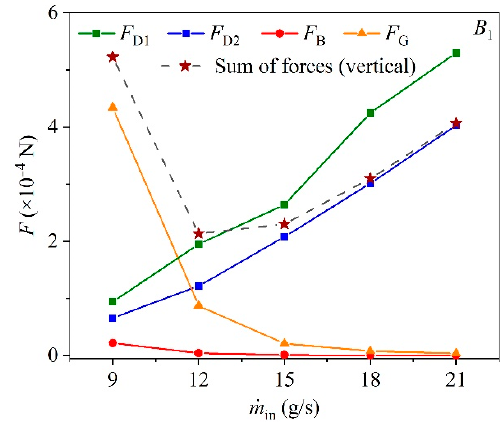
Figure 11. Forces on droplet under various ṁ in.